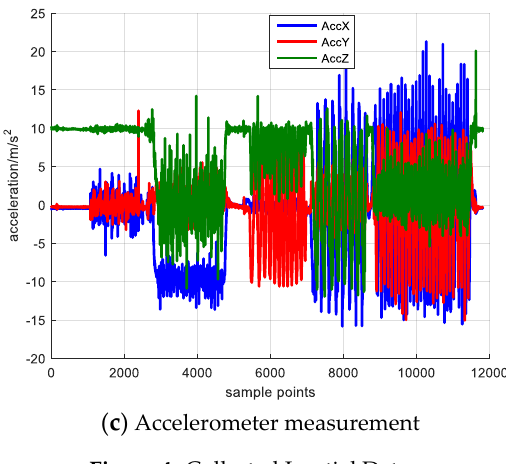
Figure 4. Collected Inertial Data.